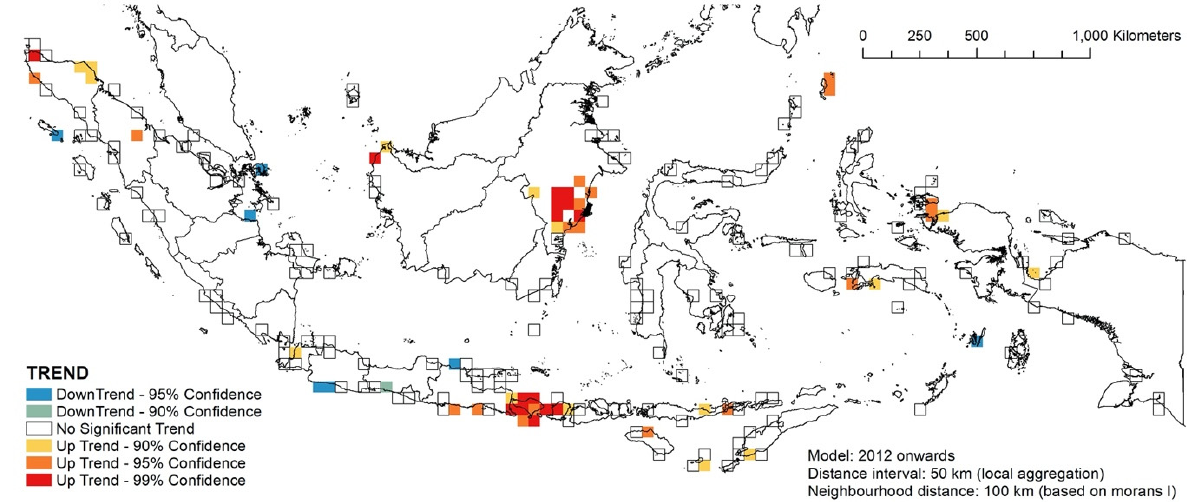
Figure 12. The temporal hotspot patterns of the 2012–2021 stranding events.